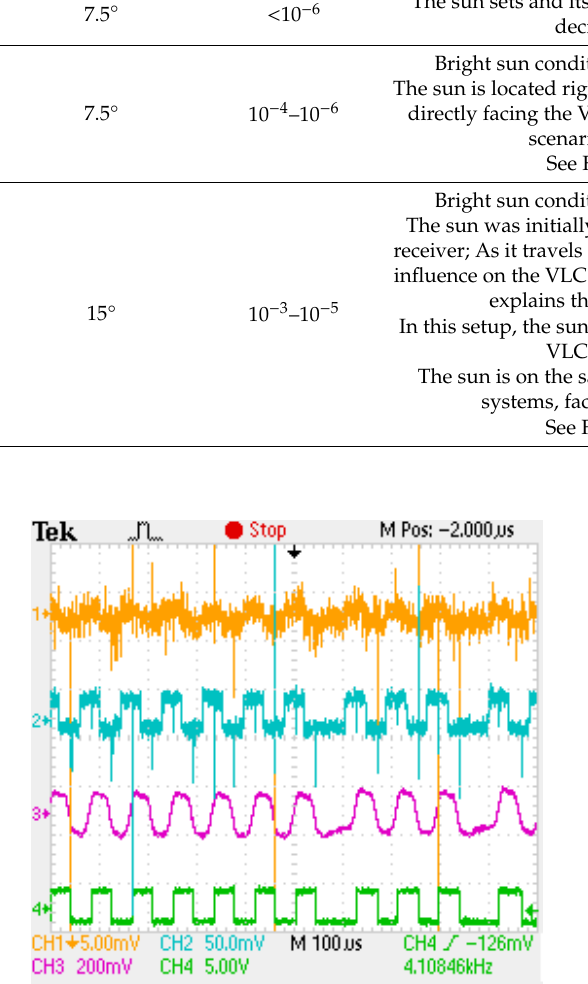
Figure 8. Scope screen illustrating the signal reconstruction process at the level of the different blocks of the VLC sensor: Channel 1 (orange) shows the output of the logarithmic transimpedance circuit; Channel 2 (blue) shows the output of the transimpedance circuit after a 24× amplification; Channel 3 (purple) shows the output of the filtering block; Channel 4 (green) shows the reconstructed signal which will be used in the data decoding process. Table 7. Summary of the experimental evaluation of the VLC system in various outdoor conditions.